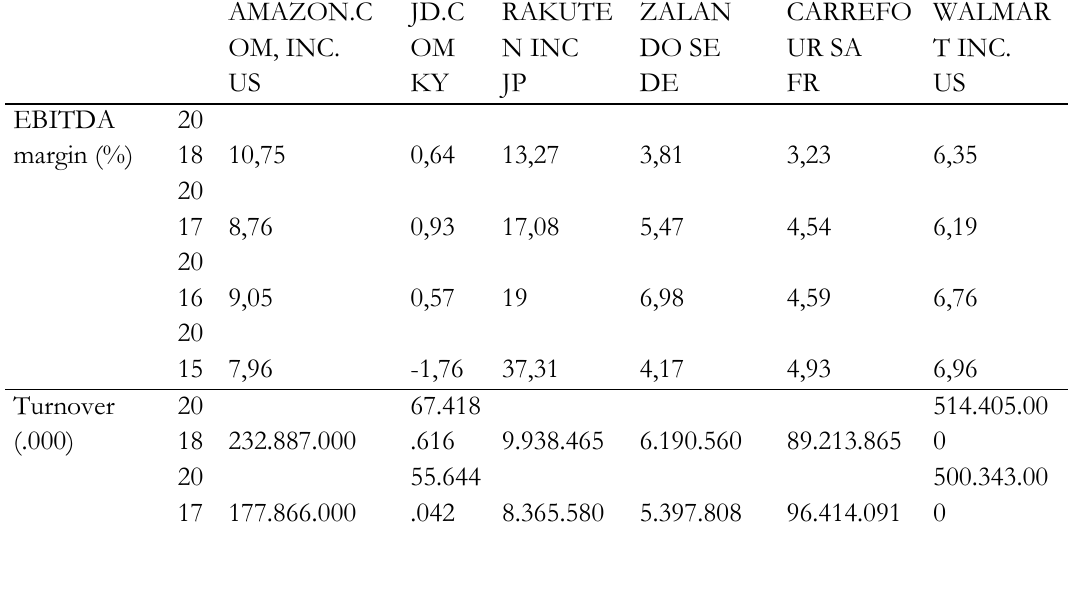
Table 2 - Comparison of balance sheet data between digital and traditional